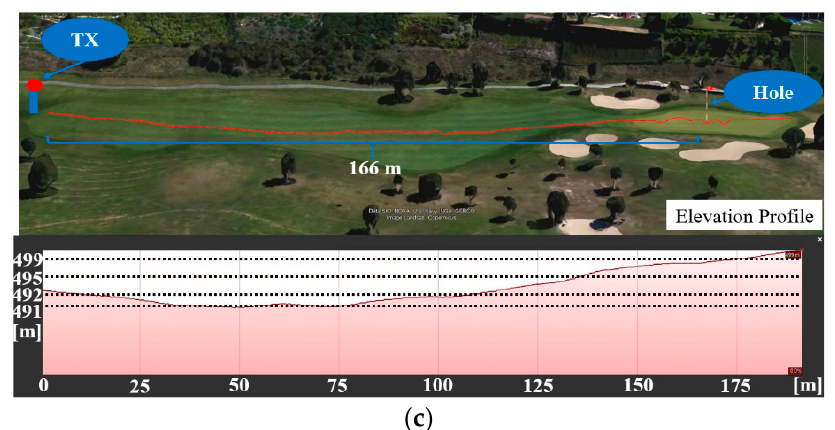
Figure 3. ( a ) Plane of Hole number 1 of the Golf Course; ( b ) Google Earth picture of the extension area of Hole 1; ( c ) Elevation profile of Hole 1.